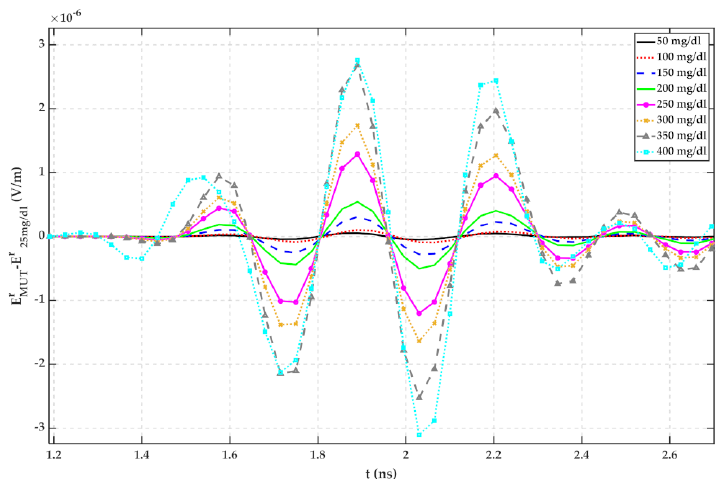
Figure 5. Simulation result for reflected signal differences of various MUTs with respect to water with 25 mg/dL